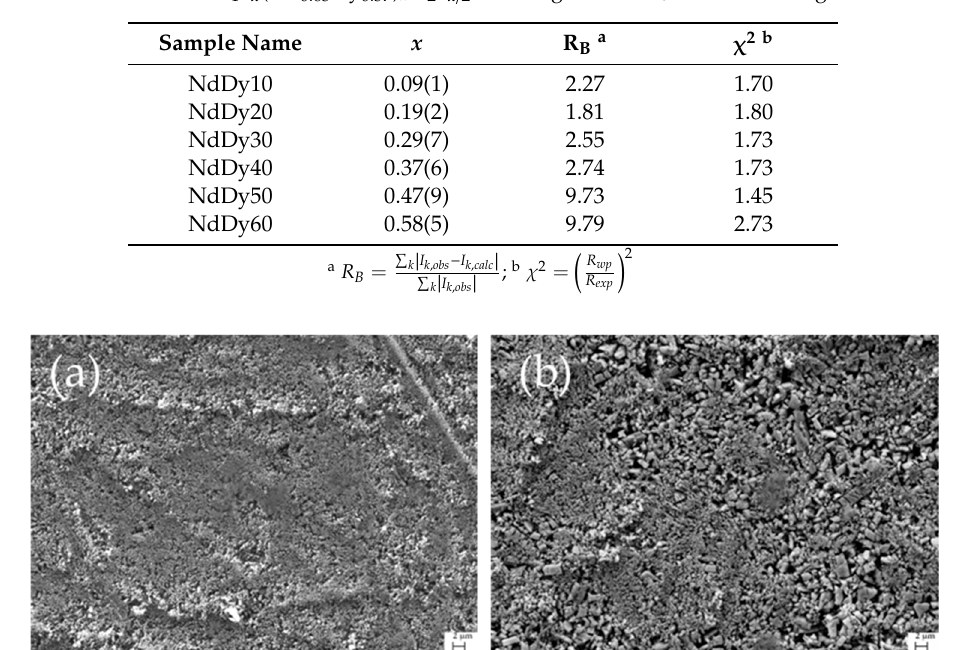
Table 1. Values of x in Ce 1 − x (Nd 0.63 Dy 0.37 ) x O 2 − x / 2 resulting from EDS, and Rietveld agreement factors.